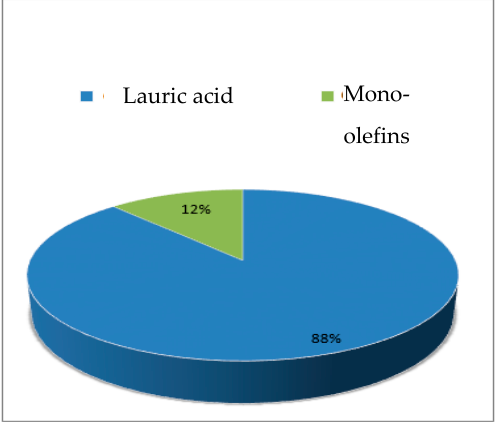
Figure 6. Compounds identified after fast pyrolysis of pure lauric acid at 650 °C.